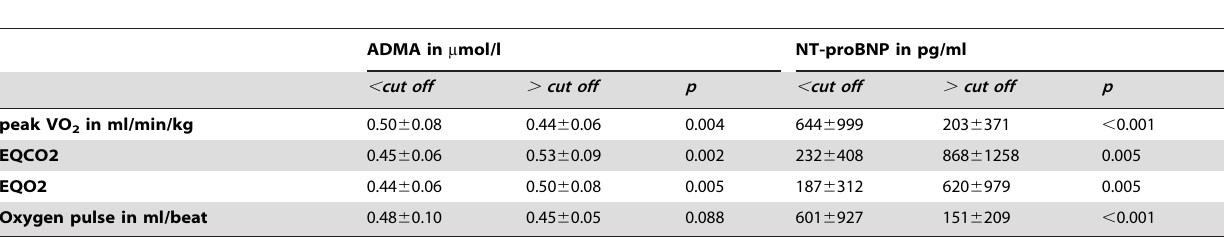
Table 4. ADMA and NT-proBNP in patients with limitations of their cardiopulmonary exercise capacity.